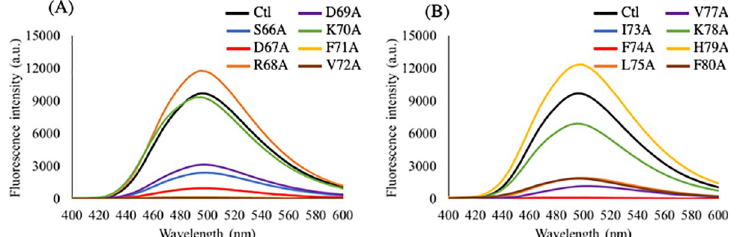
Fig 4. Emission spectra of Bis-ANS solution in the presence of the alanine substituents of α A66–80 peptides. Black lines show the emission spectrum of the Bis-ANS solution in the presence of normal α A66–80 (L-isoAsp76: Ctl). (A) Blue, red, orange, purple, green, yellow, and brown lines show the emission spectra of the Bis-ANS solution in the presence of S66A, D67A, R68A, D69A, K70A, F71A, and V72A substituents, respectively. (B) Blue, red, orange, purple, green, yellow, and brown lines show the emission spectra of the Bis-ANS solution in the presence of I73A, F74A, L75A, V77A, K78A, H79A, and F80A substituents, respectively. Each spectrum represents an average of three